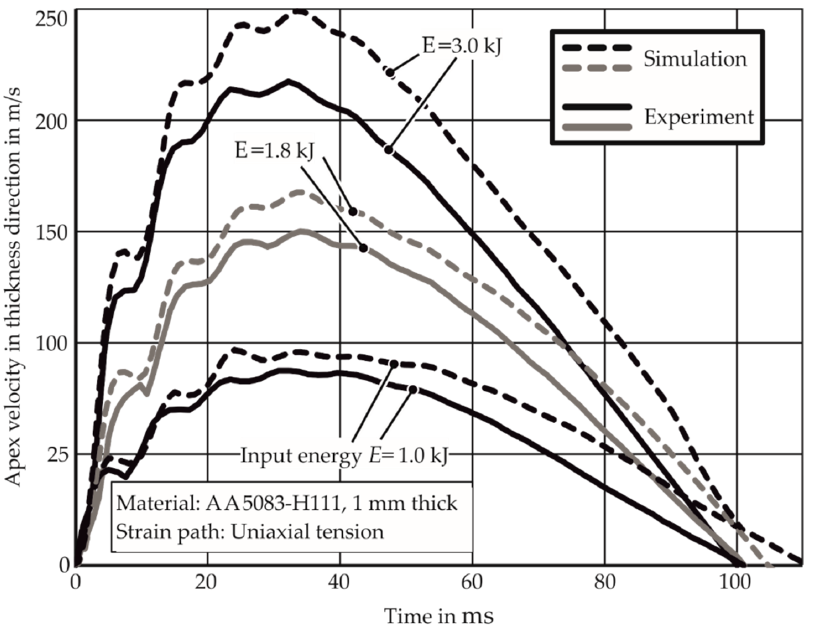
Figure 11. Measured and simulated specimen velocities during the electromagnetic forming limit test. E denotes input energy.